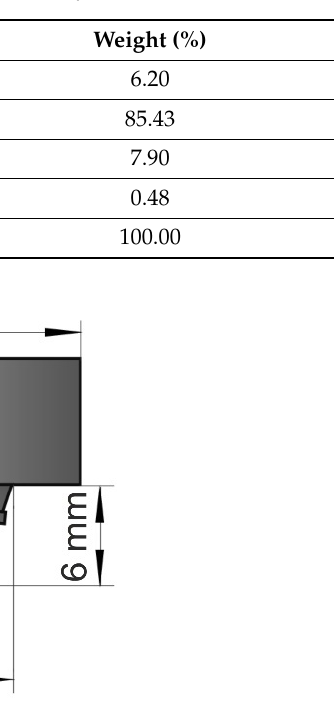
Innovatest hardness tester (Innovatest BV, Maastricht, The Netherlands); a tungsten carbide